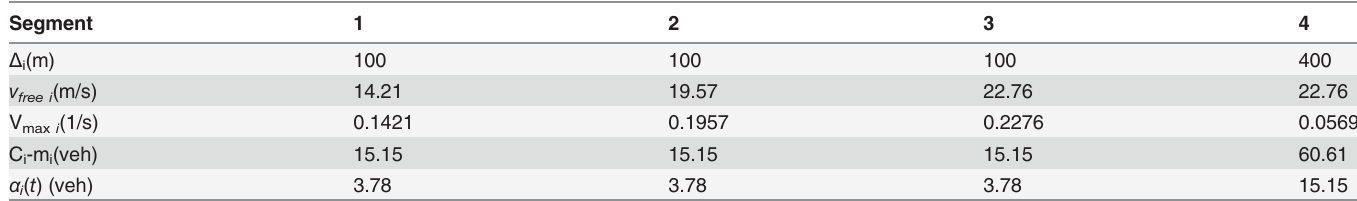
Table 1. Traf fi c parameters of VCPN.